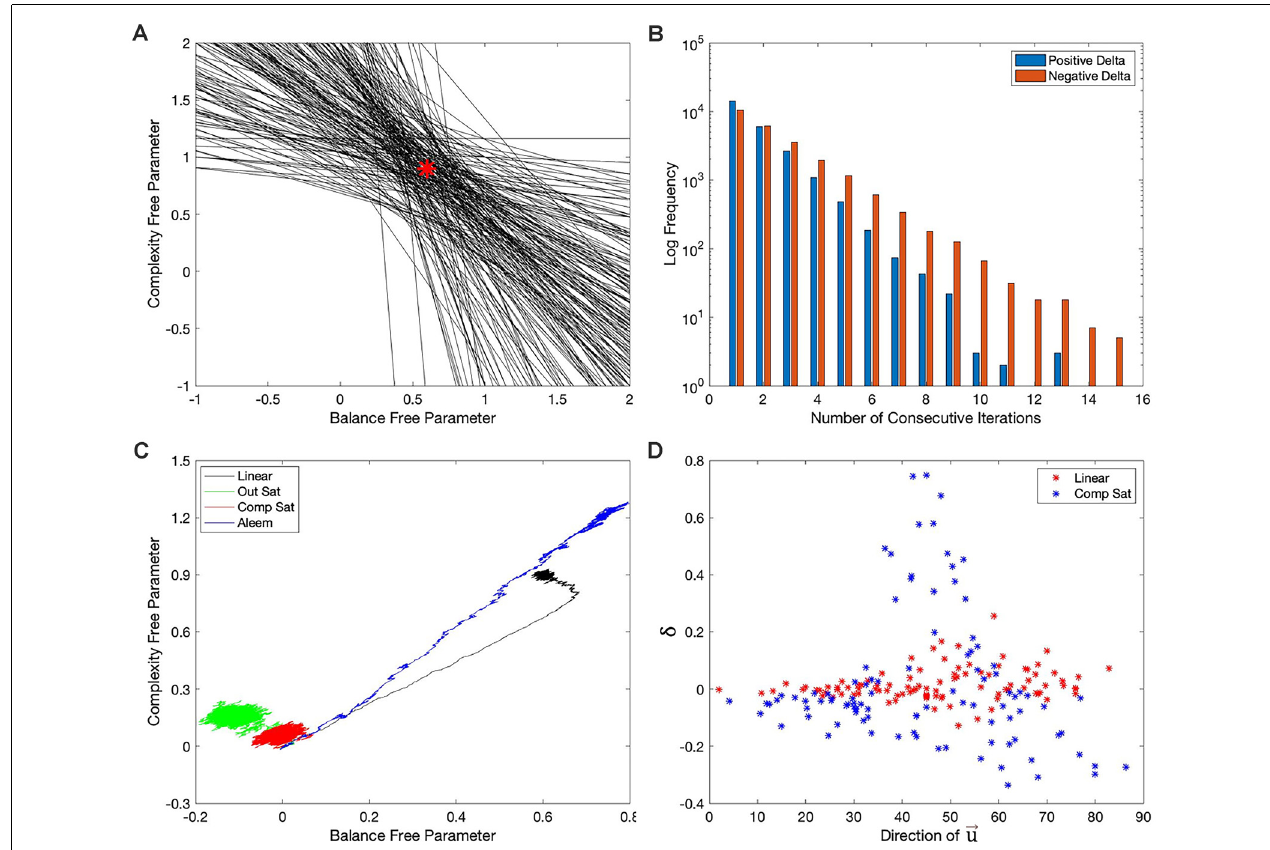
FIGURE 8 | Explanations for the failures of the hypotheses in the “Hypotheses Tested in This Article” sections. (A) First 200 target isolines in the simulations of Figure 7A . The red star indicates the parameters of the model of reward ( Table 2 ). The red star lies in the middle of the small region defined by the intersection of the target isolines. (B) Distribution of the number of consecutive iterations spent before (blue) and beyond (red) the target isolines in the last 100,000 iterations of the simulations of Figure 2B . The free parameters take longer to recover when they are beyond the target isoline than after it. (C) Phase diagram similar to Figure 2E but with the motivation function set to 1. The phase diagrams continue to exhibit curvatures, except possibly for that with the Aleem et al.’s reward model. (D) Comparison of 100 consecutive iterations (iteration 1,401 to iteration 1,500) with the linear ( Figure 2A ) and Component-saturation ( Figure 2C ) rewards models. The results with the Linear model (red dots) exhibit little correlation between δ and the direction of (cid:69) µ . But a strong, complex correlation is evident for the Component-saturation model